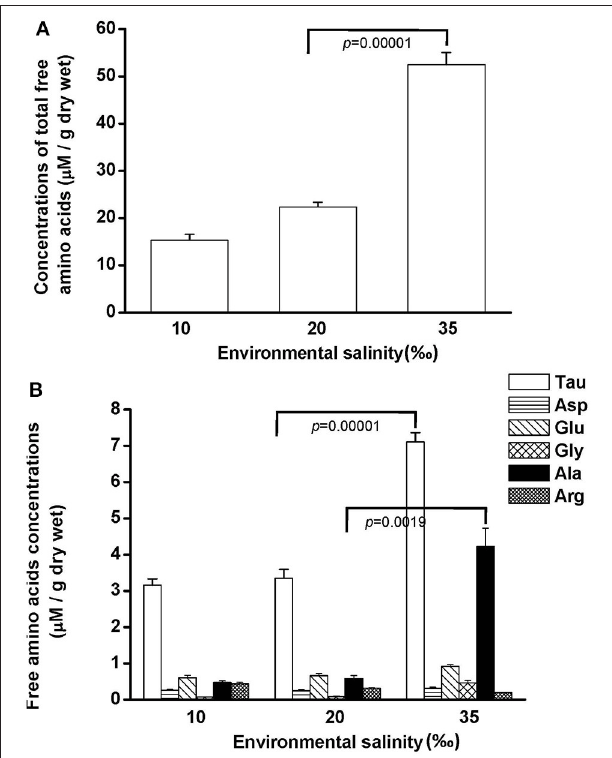
FIGURE 4 | Salinity effects on concentrations of total free amino acids (A) and different free amino acids (B) in mantles of the hard clam. Statistical analysis was performed with one-way ANOVA followed by Dunnett’s test. The 20 ‰ SW group was used a control. p < 0.05 was considered statistically significant. Asterisk indicates the significant difference ( p < 0.05). Values are means ± SEM. ( N = 8). Tau, taurine; Asp, aspartate;